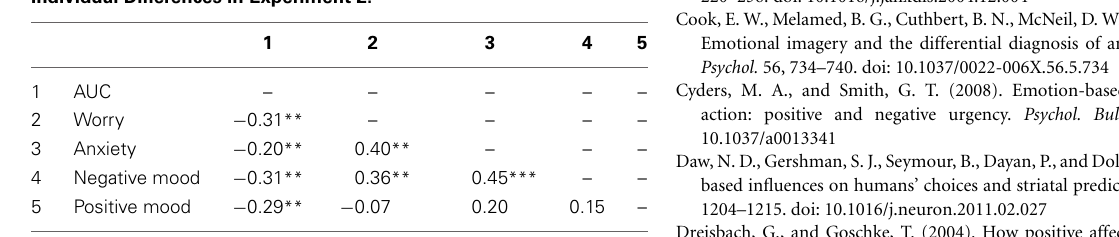
Table 3 | Correlations Between Area Under the Curve (AUC) and Individual Differences in Experiment